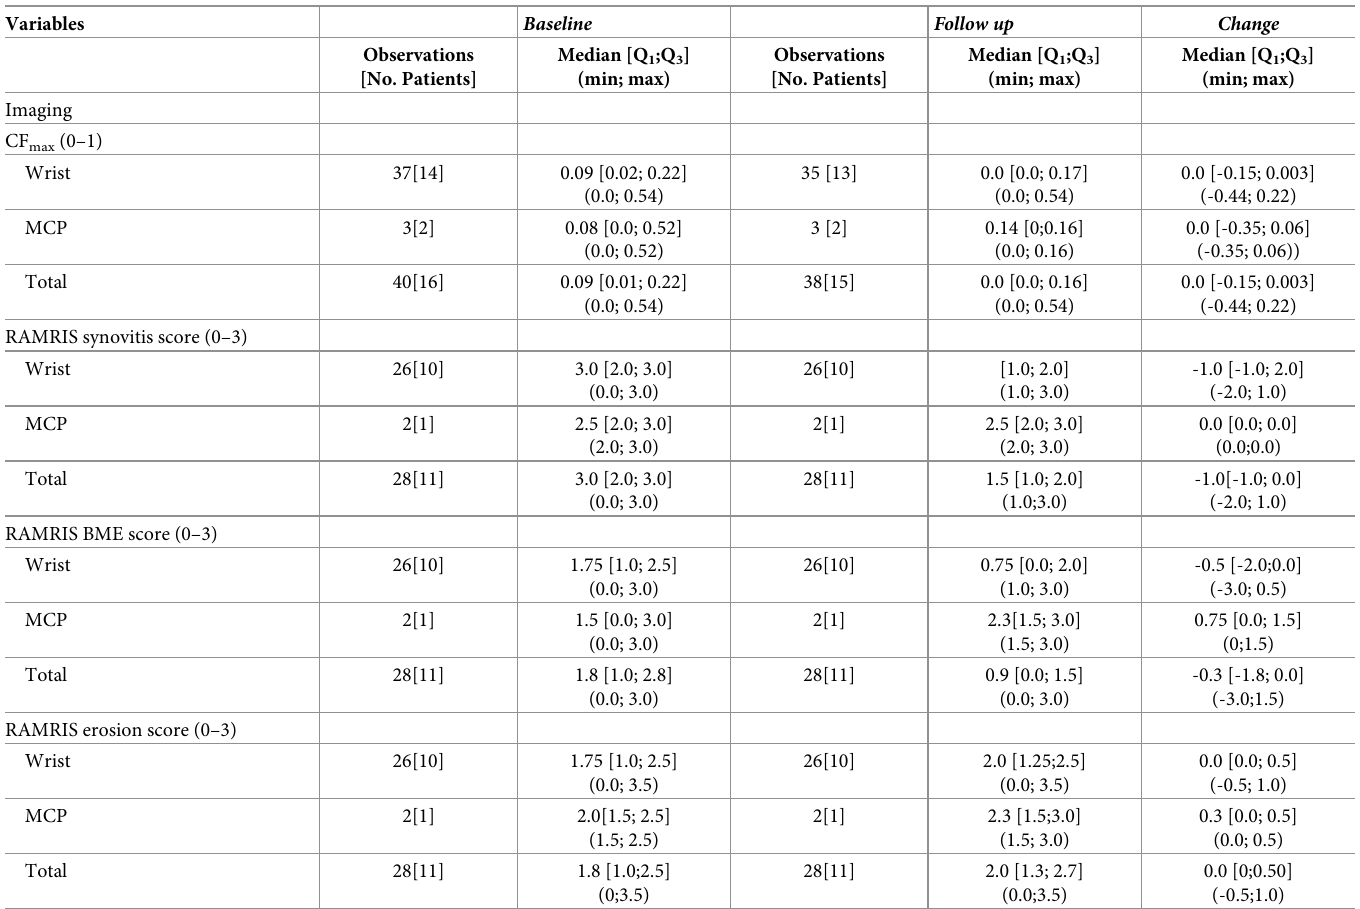
Table 2. An overview of global imaging activity during the study period.